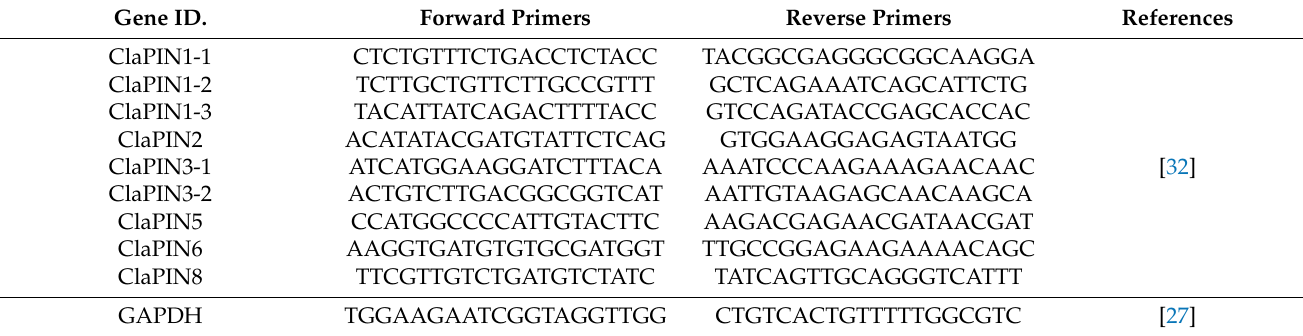
Table 2. Primers of watermelon 9 PIN genes and GAPDH gene (as the endogenous control) used for qRT-PCR. Gene